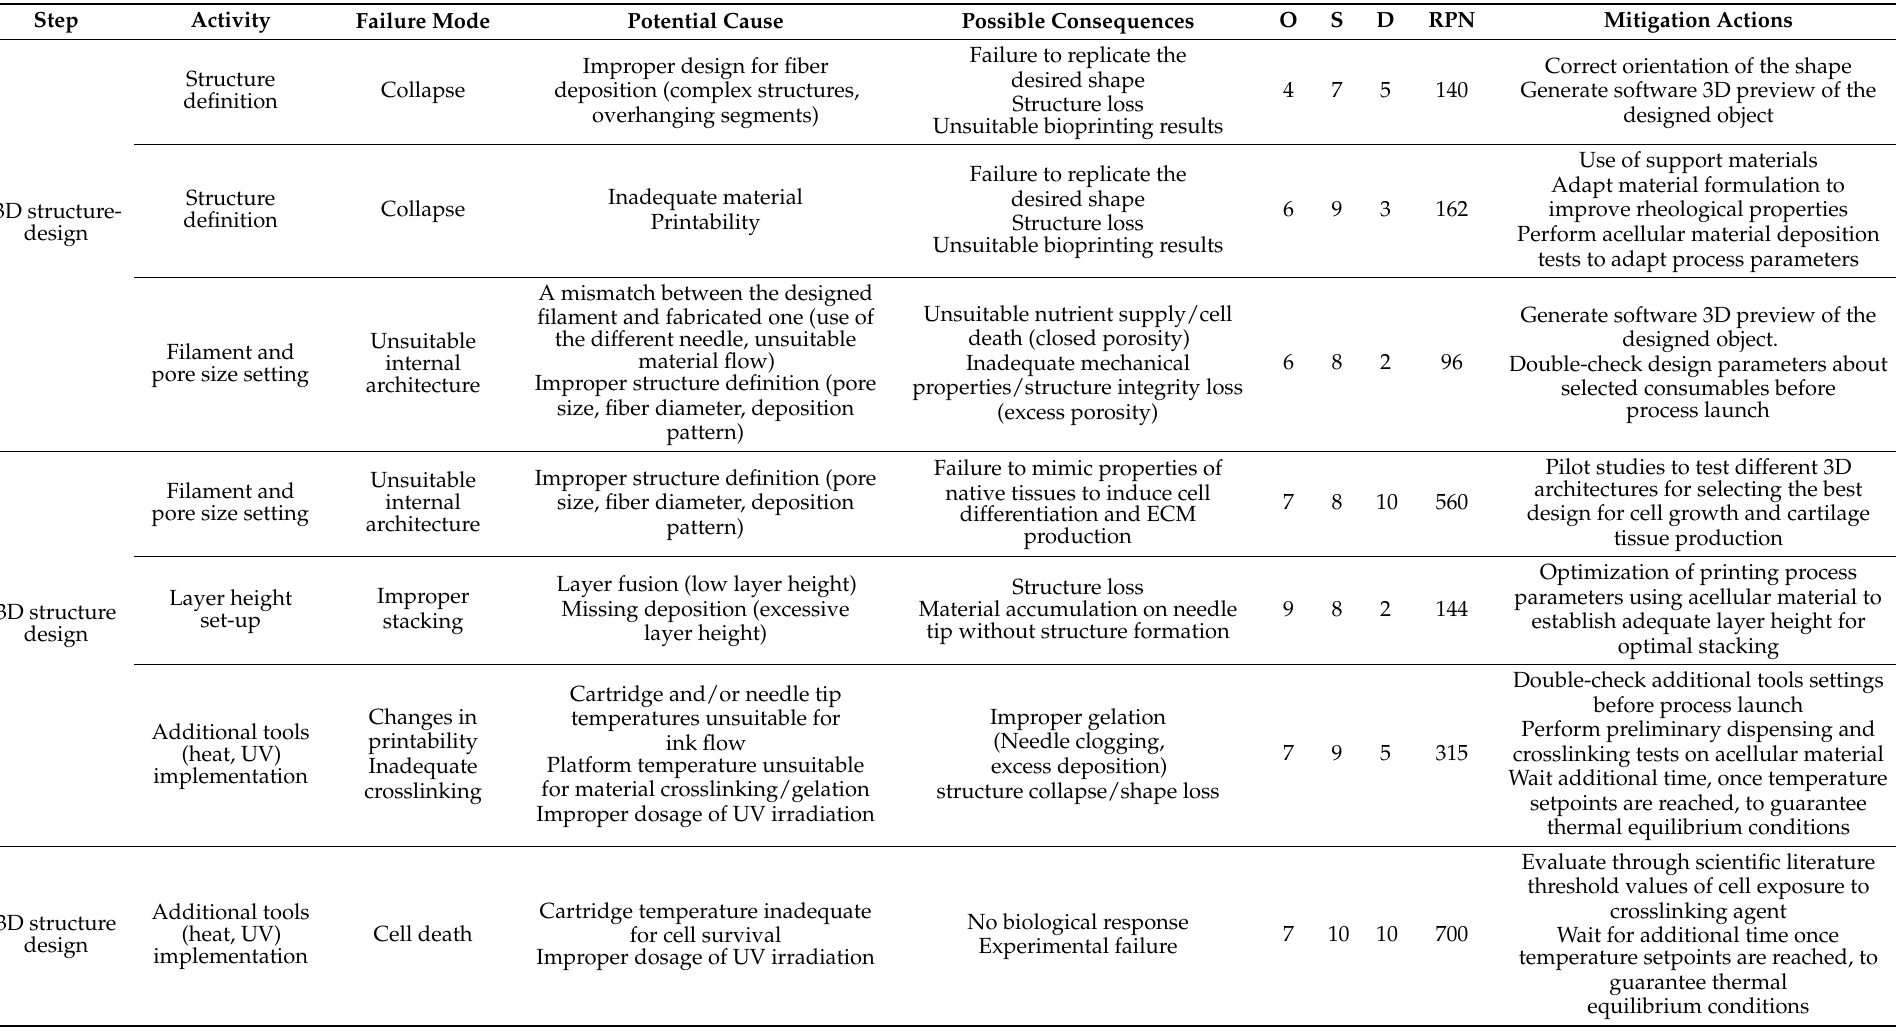
Table 4. FMEA/FMECA of the pre-bioprinting phase and process preparation